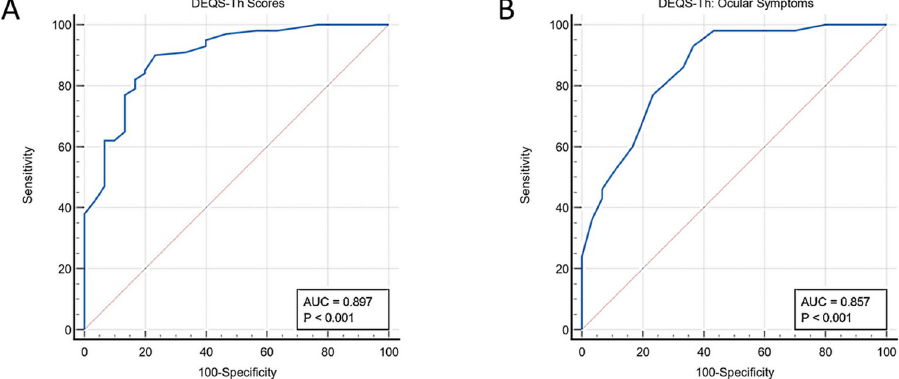
Fig 1. Receiver operating characteristic curve of the DEQS-Th scores (A) and the Short Form DEQS-Th scores (B) for the prediction of dry eye disease diagnosis. DEQS-TH; the Thai version of the Dry Eye-Related Quality-of-Life Score.